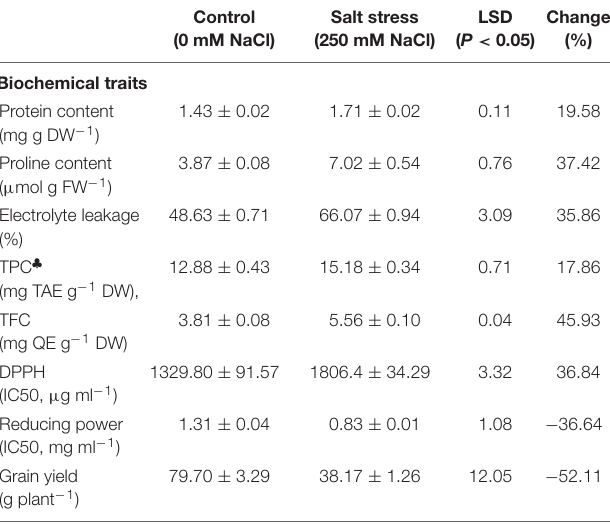
TABLE 2 | Means ( ± SE) of biochemical properties and grain yield of the genotypes studied under control and salt stress conditions.